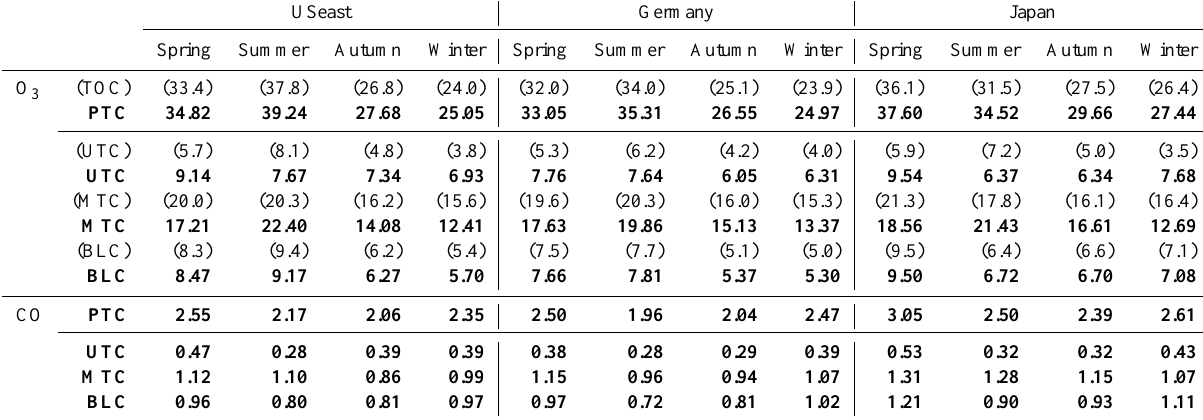
Table 4. Pure tropospheric columns PTC( X,s ) and related partial columns, UTC( X,s ), MTC( X,s ) and BLC( X,s ), where X is O 3 and CO at season s over USeast, Germany and Japan in DU and in × 10 18 moleculescm − 2 , respectively. These results are in bold. For O 3 , the additional small numbers/letters in parentheses refer to previous values on incomplete tropospheric columns (TOC) and partial columns as given in Zbinden et al. (2006). MTC and UTC (bold) are derived using the new L d